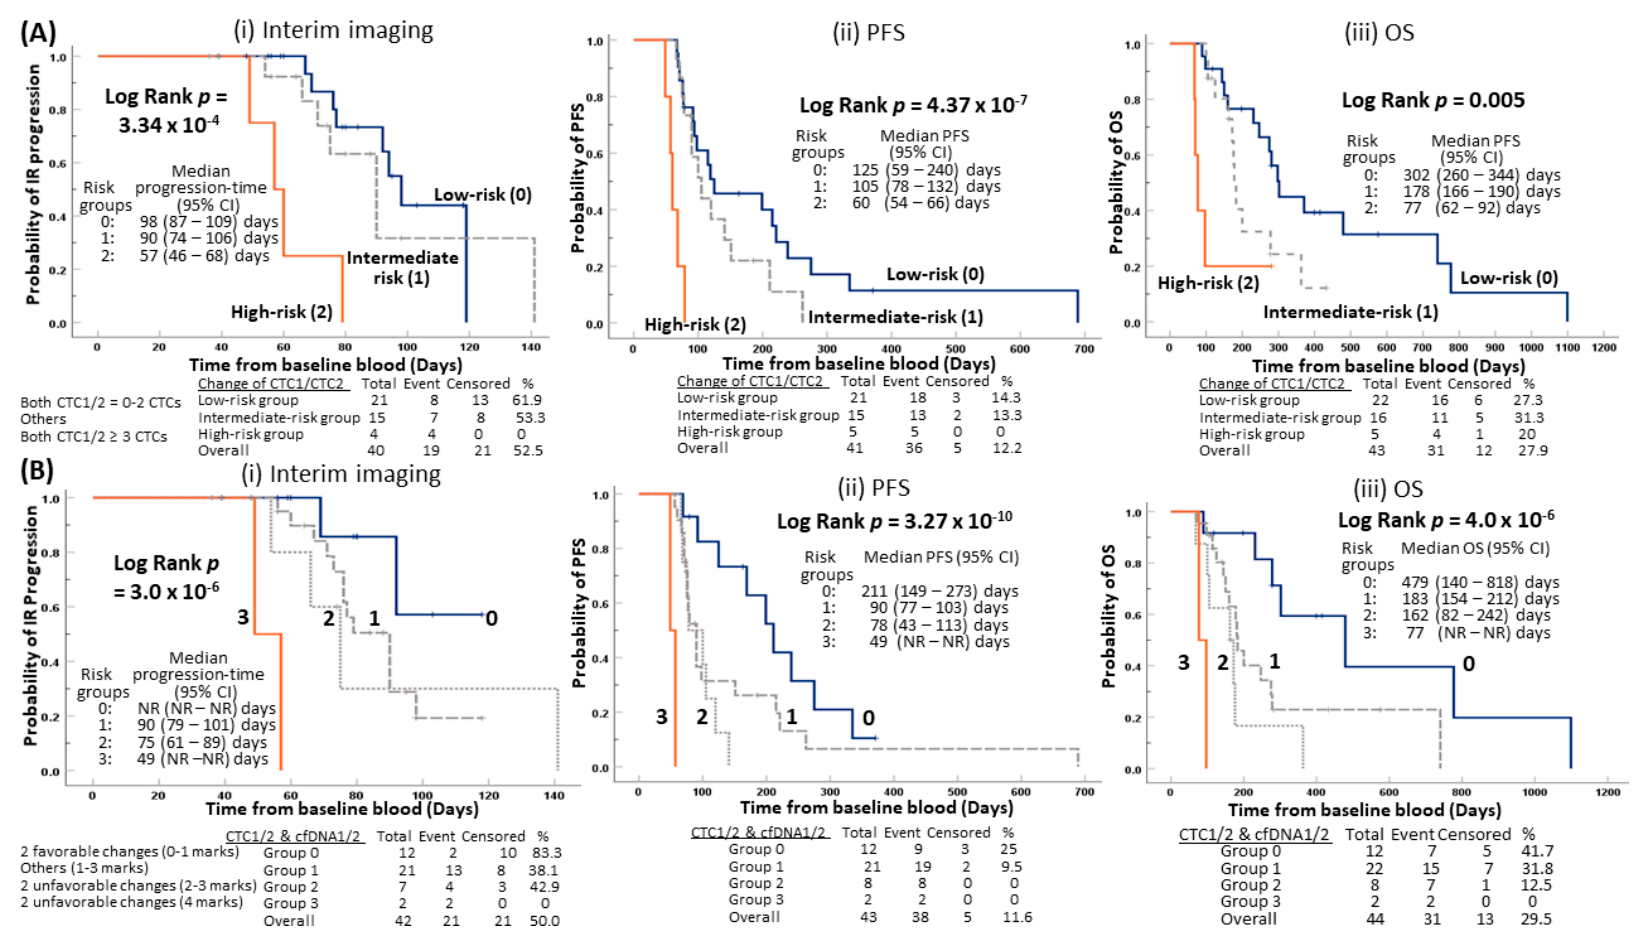
Figure 3. Risk stratification of disease progression. Change of CTC1/CTC2 (A), combined changes of CTC and cfDNA (B) were associated with interim reassessment imaging, PFS, and OS.